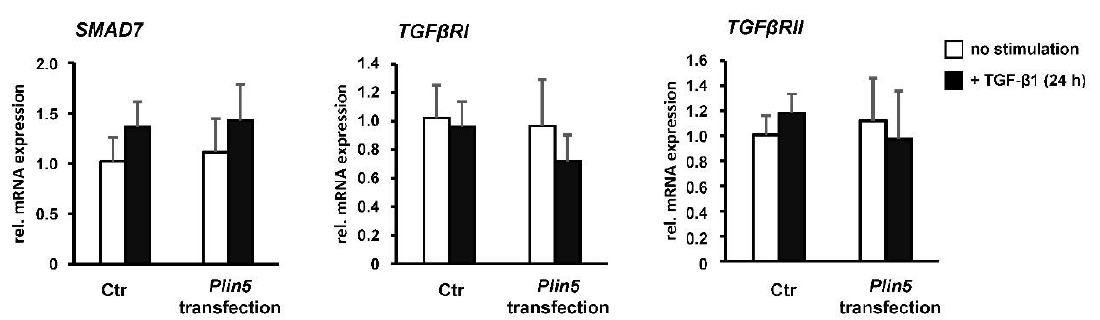
Figure 6. PLIN5 overexpression and TGF- β 1 stimulation have no significant effect on inhibitory Smad7 . Plin5 - transfected LX-2 cells stimulated with TGF- β 1 (2.5 ng/mL) for 24 h or left unstimulated. All experiments were performed in triplicate.